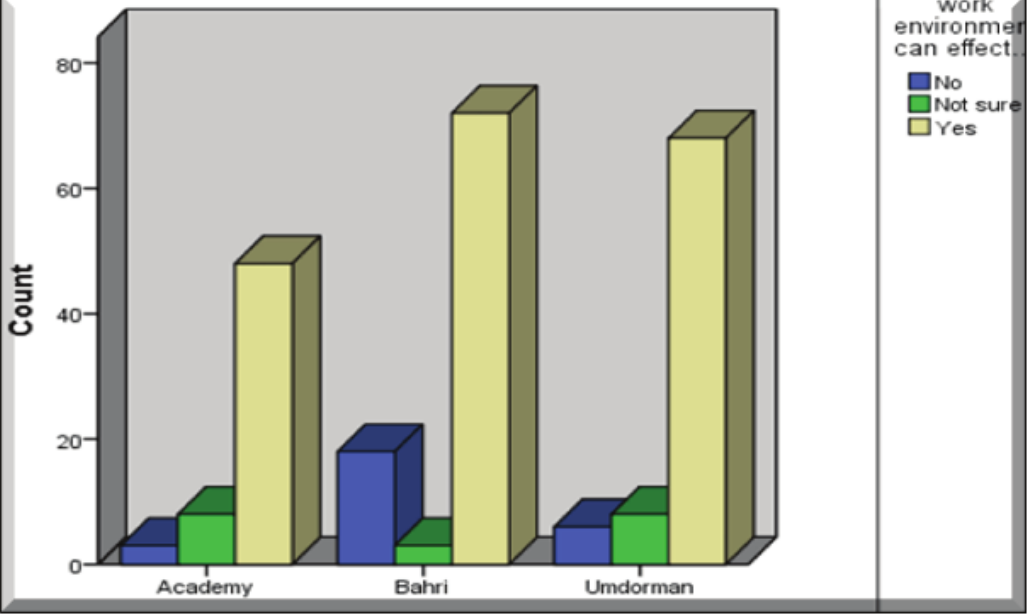
Figure 1: Shows the participants response regarding work environment can effect on patient’s safety or